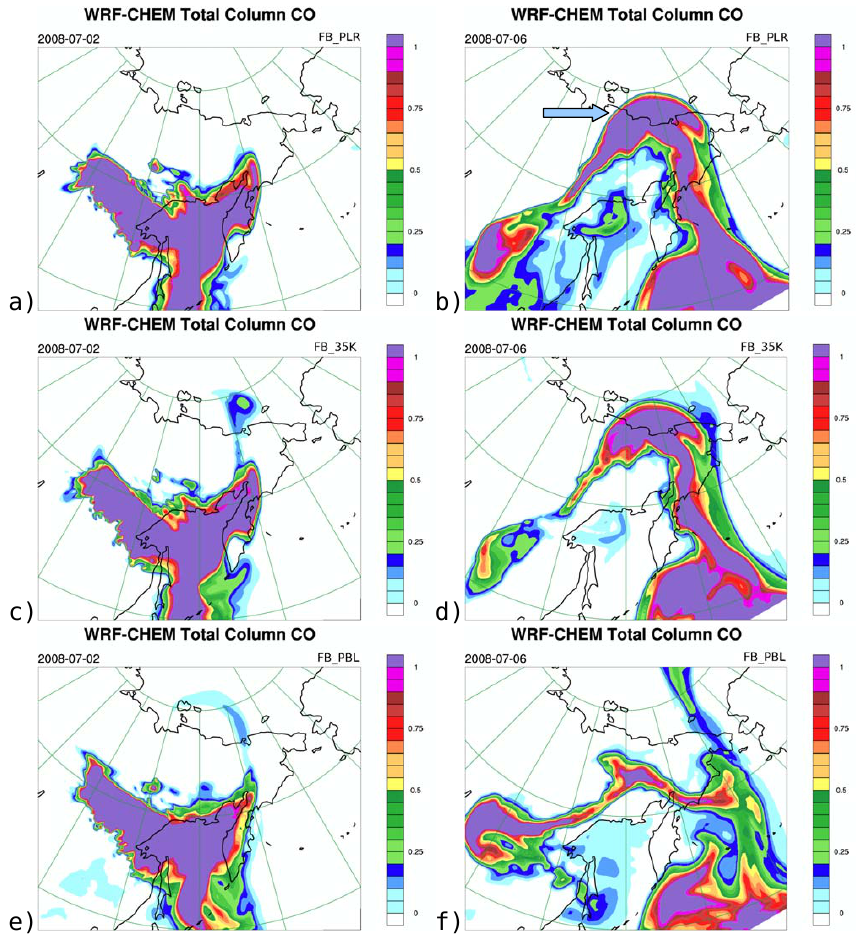
Fig. 10. Normalized WRF-Chem Total Column CO for the Russian plume over Asia and the western Pacific Ocean for a, b) FB_PLR, c, d) FB_35K, and e, f ) FB_PBL for a, c, d) 2 July and b, d, e) 6 July 2008. The arrow in panel b) denotes one of the plumes discussed in the Arctic transport section.